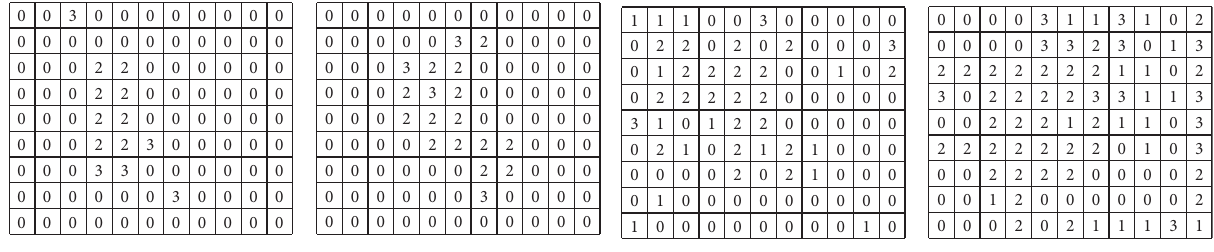
Figure 3: Temporal visual perception characteristics